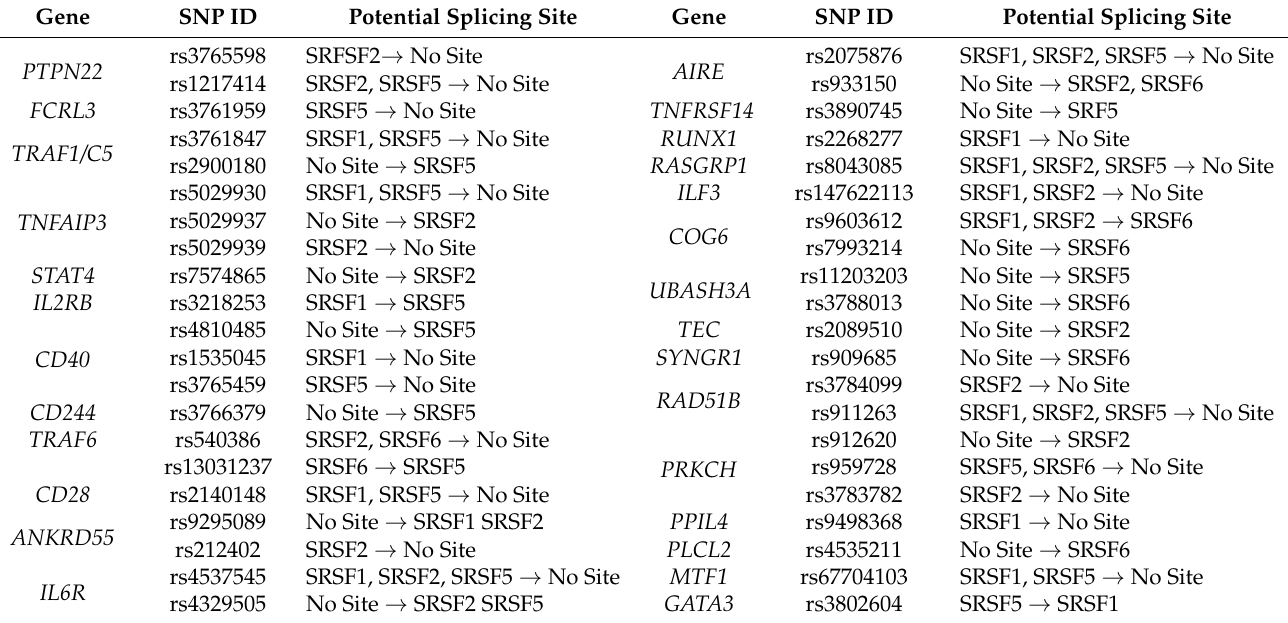
Table 8. Intronic SNP effect on splicing site as predicted by ESEfinder